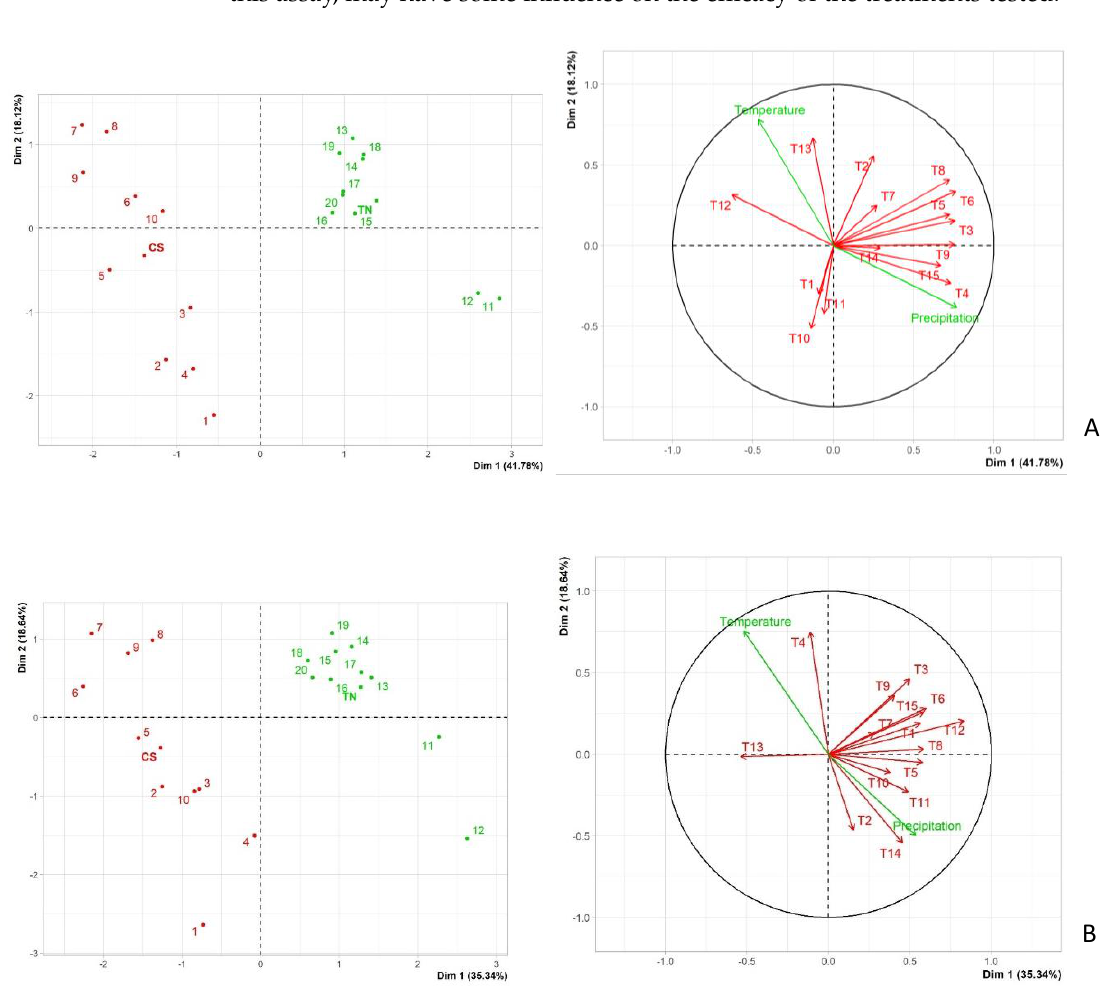
Figure 4. Principal component analysis (PCA) for the interactions of all treatments, 15 variables including all the product/isolate combinations (T represents the treatment numbers which are stated in Table 2), as well as inoculated controls on both variables and the meteorological variables (Figure 2). Red marks represent the observations for Cabernet Sauvignon (CS) and green marks represent the Touriga Nacional (TN) observations. ( A )-PCA analysis for 2019; ( B )-PCA analysis for 2020.